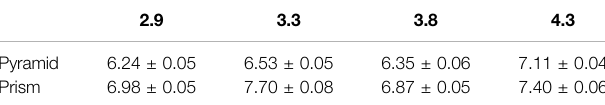
Figure 9 . The speci fi c NLA coef fi cient β values are shown in Table 4 and Table 5 .